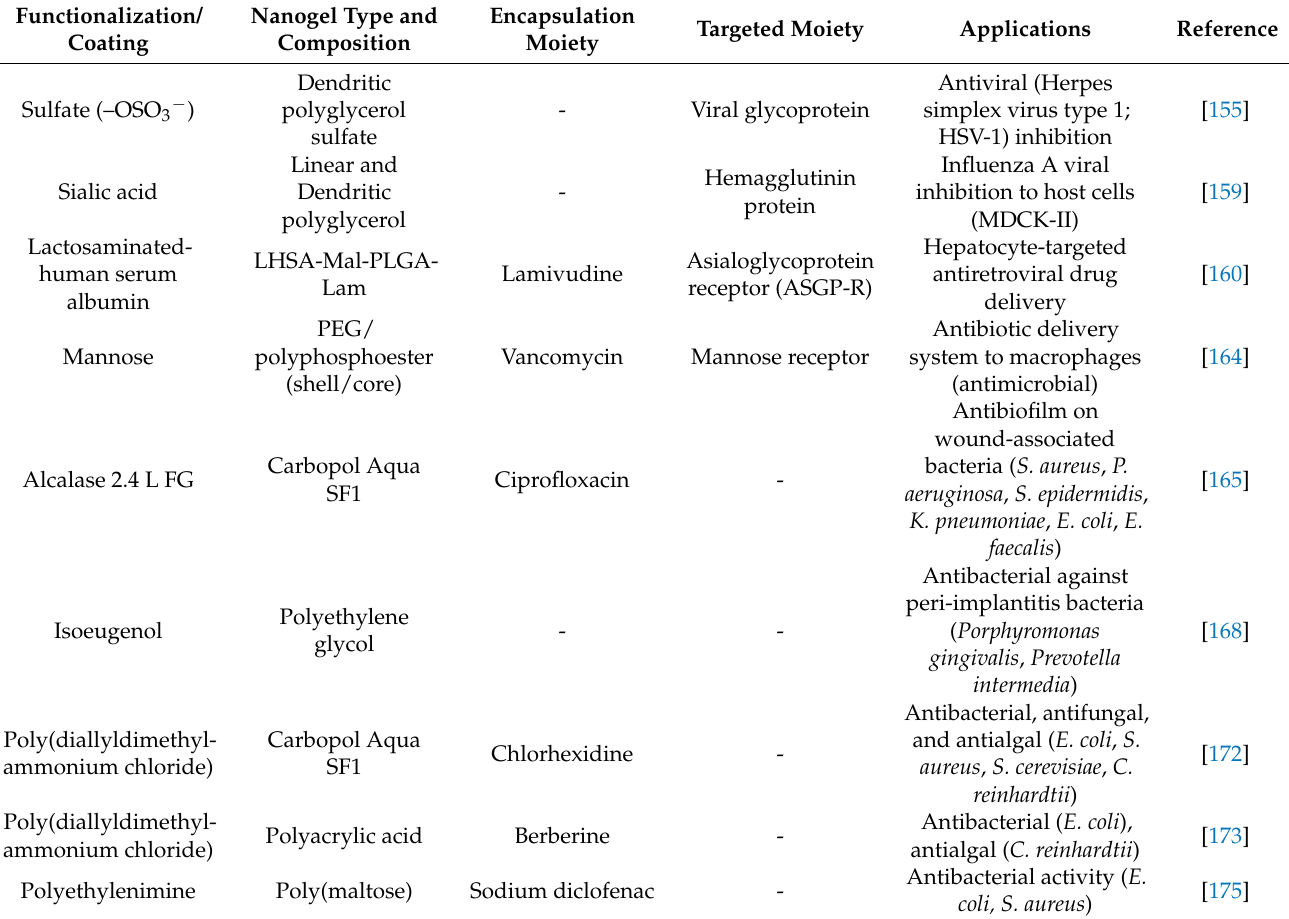
Table 4. Functionalized NG-based approaches in wound healing, antiviral and antimicrobial